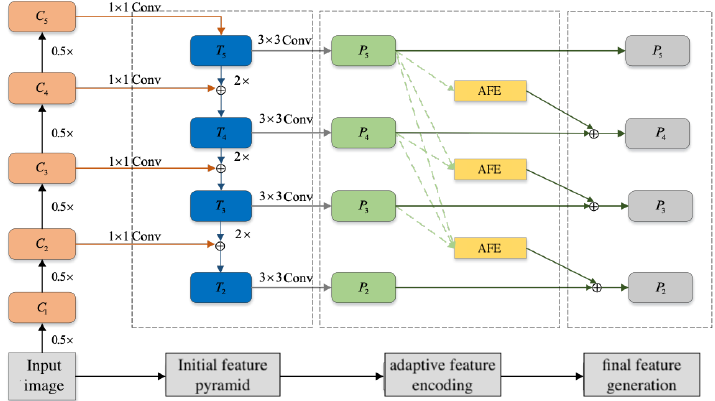
Figure 6. Description of the final feature pyramid